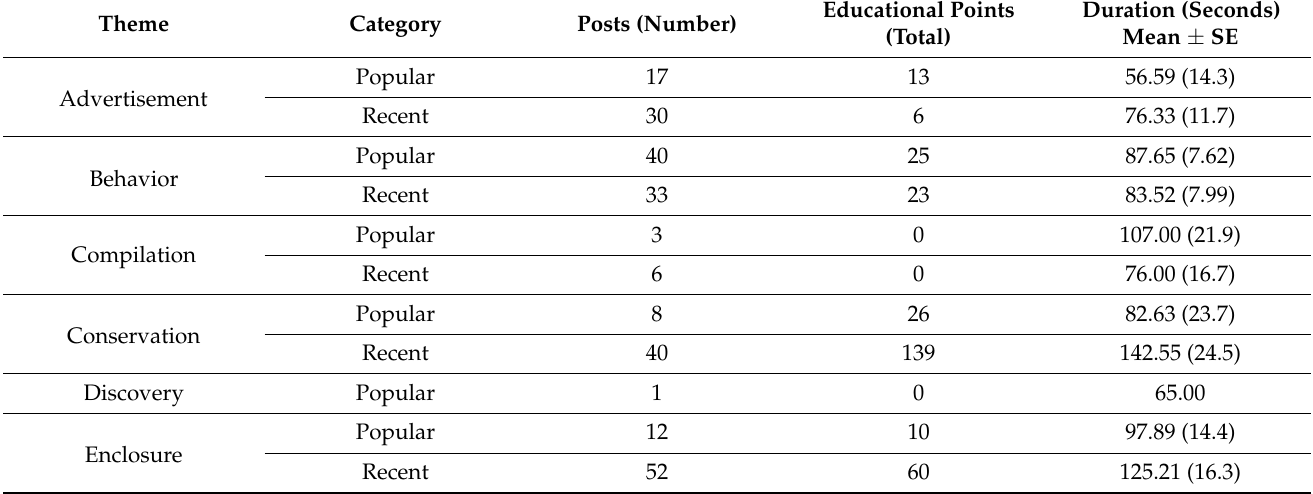
Table 5. Themes and education, the number of posts and corresponding sum of educational points and average duration for the combined most popular and most recent YouTube video themes from the subsample of three zoos.